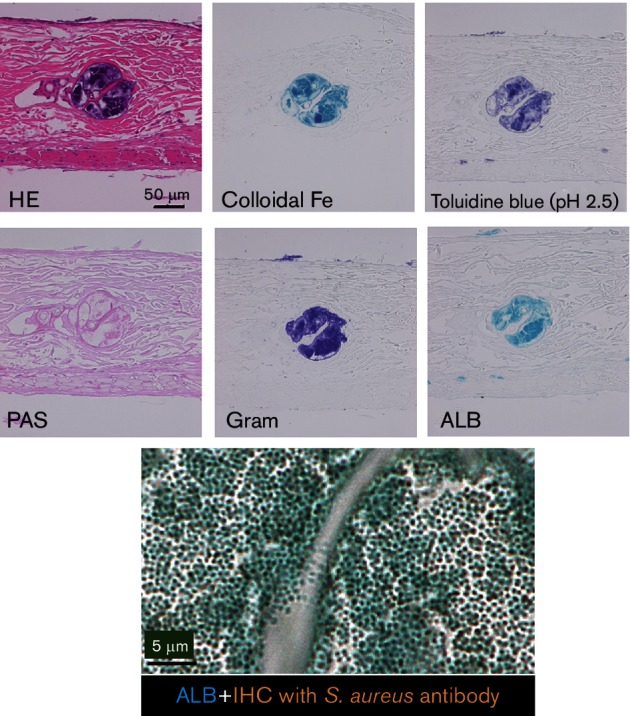
Detection of MRSA colonies and their biofilm matrix on DCs. An MRSA clinical isolate (OJ-1) was used. Colonies were developed inside the internal root sheath of the DCs following 24 h incubation with the bacterial culture. Serial sections were subjected to haematoxylin–eosin (HE) staining, Gram staining and immunostaining using an anti-S. aureus antibody. PAS staining for neutral mucopolysaccharide and acidic mucopolysaccharide staining, specifically Fe colloid staining, toluidine blue staining (pH 2.5) and ALB staining (pH 2.5), were also performed. Bacterial cells and EPS were examined by double staining using ALB and S. aureus antibody (ALB+IHC). The surrounding matrix (blue) was positive for acidic mucopolysaccharides. Bars, 50 µm in serial staining, 5 µm in double staining.